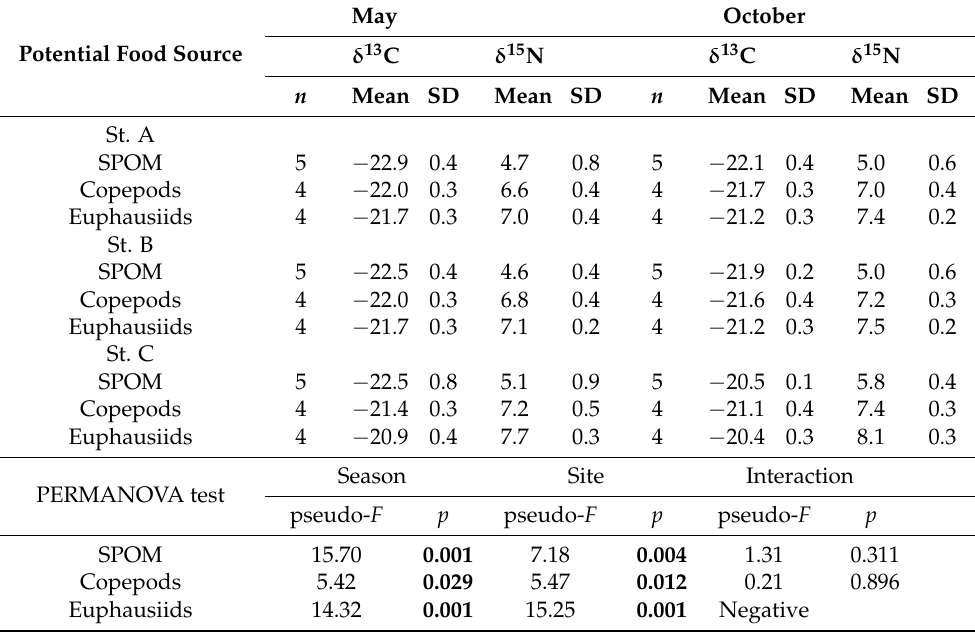
Table 3. δ 13 C and δ 15 N values of organic matter (SPOM, suspended particulate organic matter) and zooplankton (calanoid copepods and euphausiids) collected during May and October 2020 in the East Sea (St. A and St. B) and the South Sea (St. C). PERMANOVA test of δ 13 C and δ 15 N values for each potential food source between seasons and among sampling sites. Bold-face font indicates significance at p < 0.05. Data represent mean ± 1